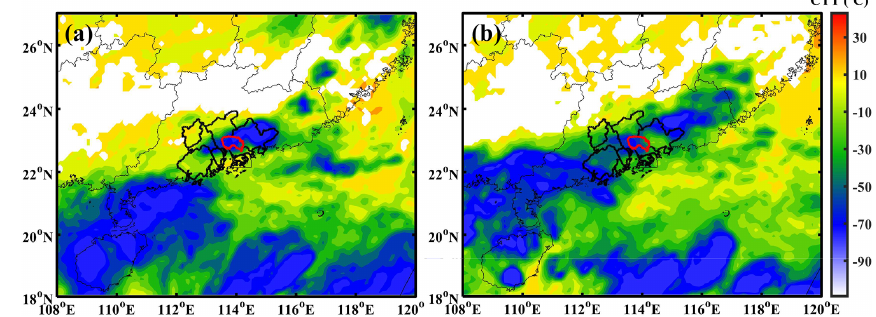
Figure 9. Spatial distribution of cloud-top temperature (CTT) at (a) 18:00LT and (b) 21:00LT on 3 September 2019.